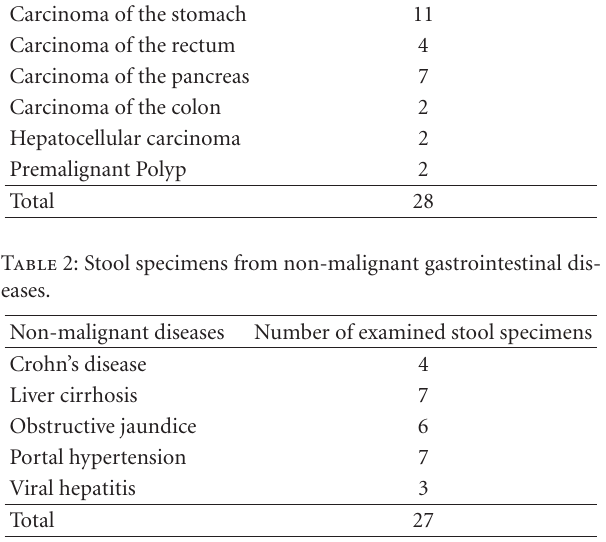
Table 1: Stool specimens from malignant gastrointestinal diseases. Malignant diseases